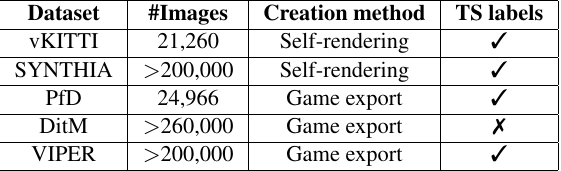
Table 1. Preselected datasets with synthetic images of street scenes with traffic signs